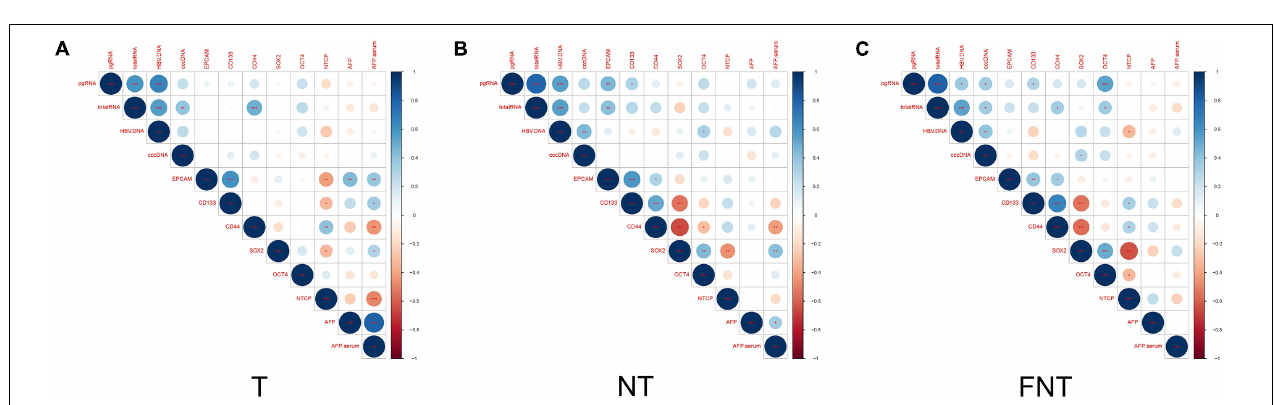
FIGURE 5 | Correlation of CSCs markers and HBV related markers. Correlation between HBV markers (DNA, cccDNA, total RNA, and pgRNA) within T (A) , NT (B) , and FNT (C) groups. The intersection of the column and row indicates the correlation between the two variables, the color of the circle indicates positive and negative correlation (blue for positive correlation, red for negative correlation), and the diameter of the circle indicates the size of the correlation coefficient. Statistical analysis was performed by Spearman rank correlation test * p < 0.05; ** p < 0.01; *** p < 0.001.